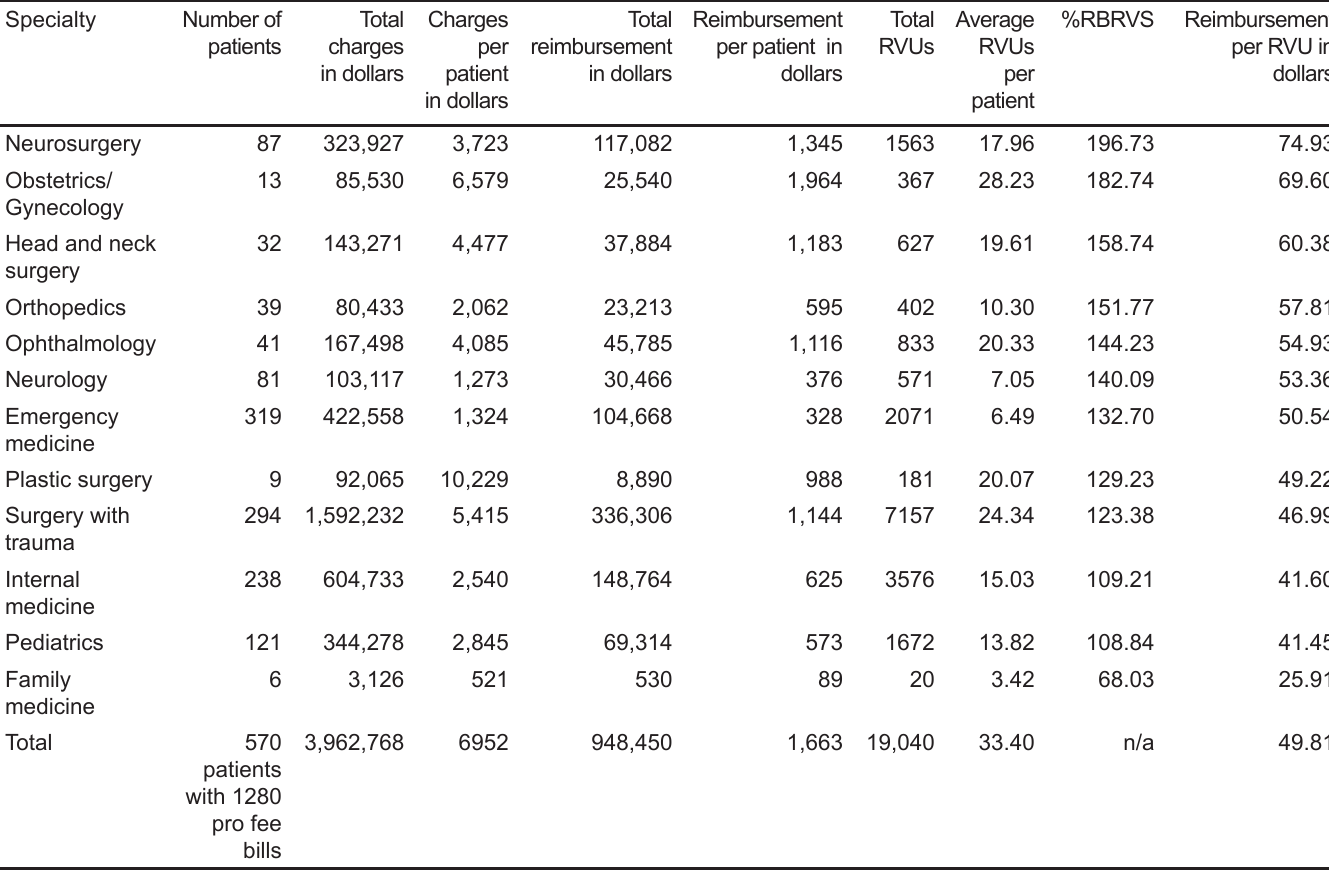
Table 1 . Reimbursements, charges, and number of patients, RVUs, average RVUs per patient, % RBRVS, and reimbursement per RVU by specialty for HLOC transfer patients across 12 specialties, organized from highest to lowest by reimbursement per RVU.